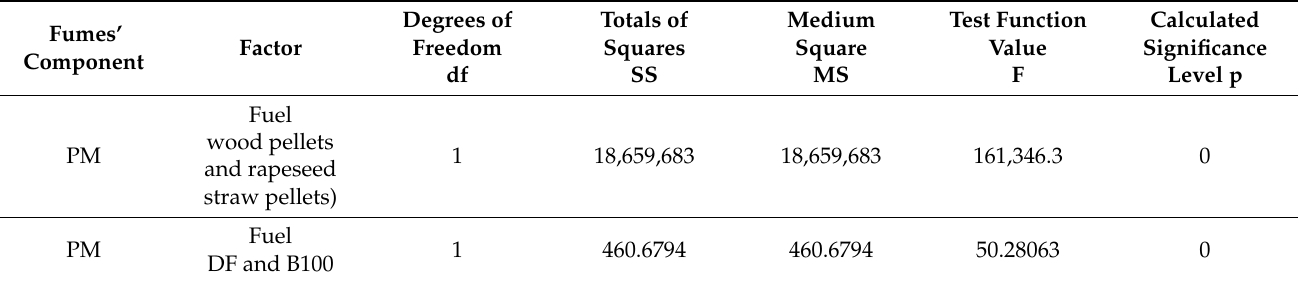
Table 5. ANOVA results for PM emission levels (mg · m − 3 ) due to